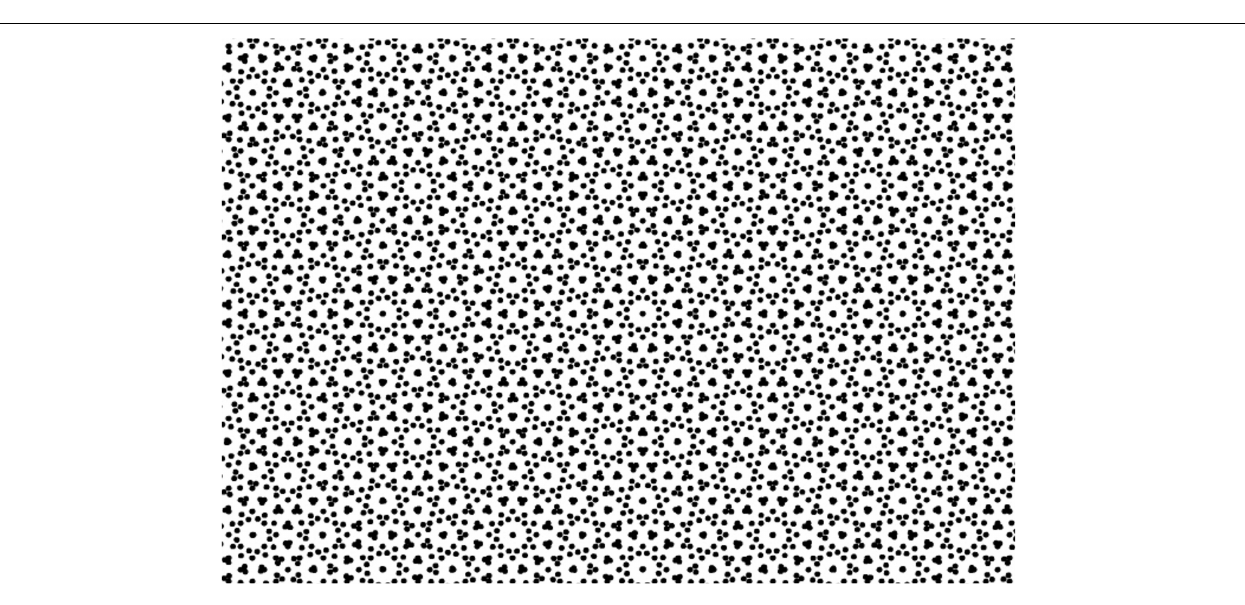
FIGURE 13 | The multiply-ambiguous Marroquin texture (Marroquin, 1976). On sustained viewing, this texture spontaneously reorganizes into multifold Gestalt organizations, even with sustained fixation at one point, revealing the dynamic flux of perceptual analysis and hypothesis testing in a vivid fashion (See Tyler,